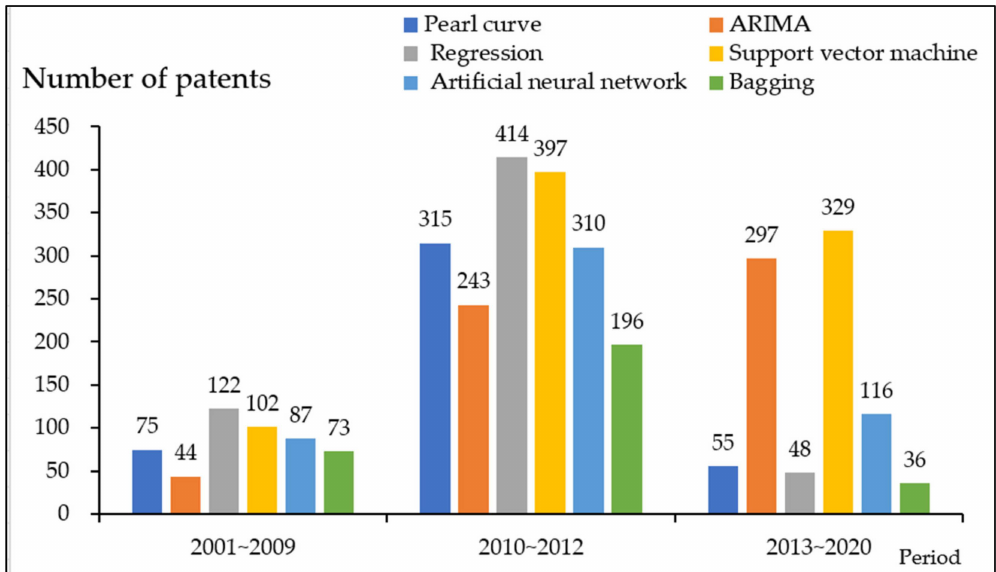
Figure 5. Mean absolute error (lower means more accurate). (2) The posterior error test